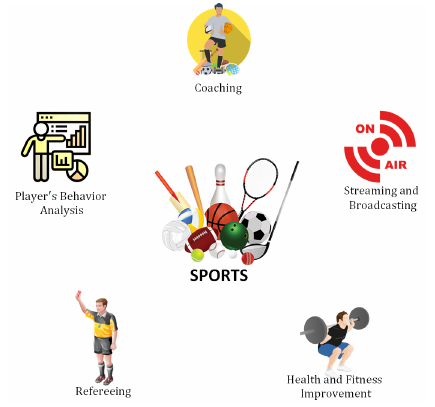
Figure 20. Applications of DL in sports